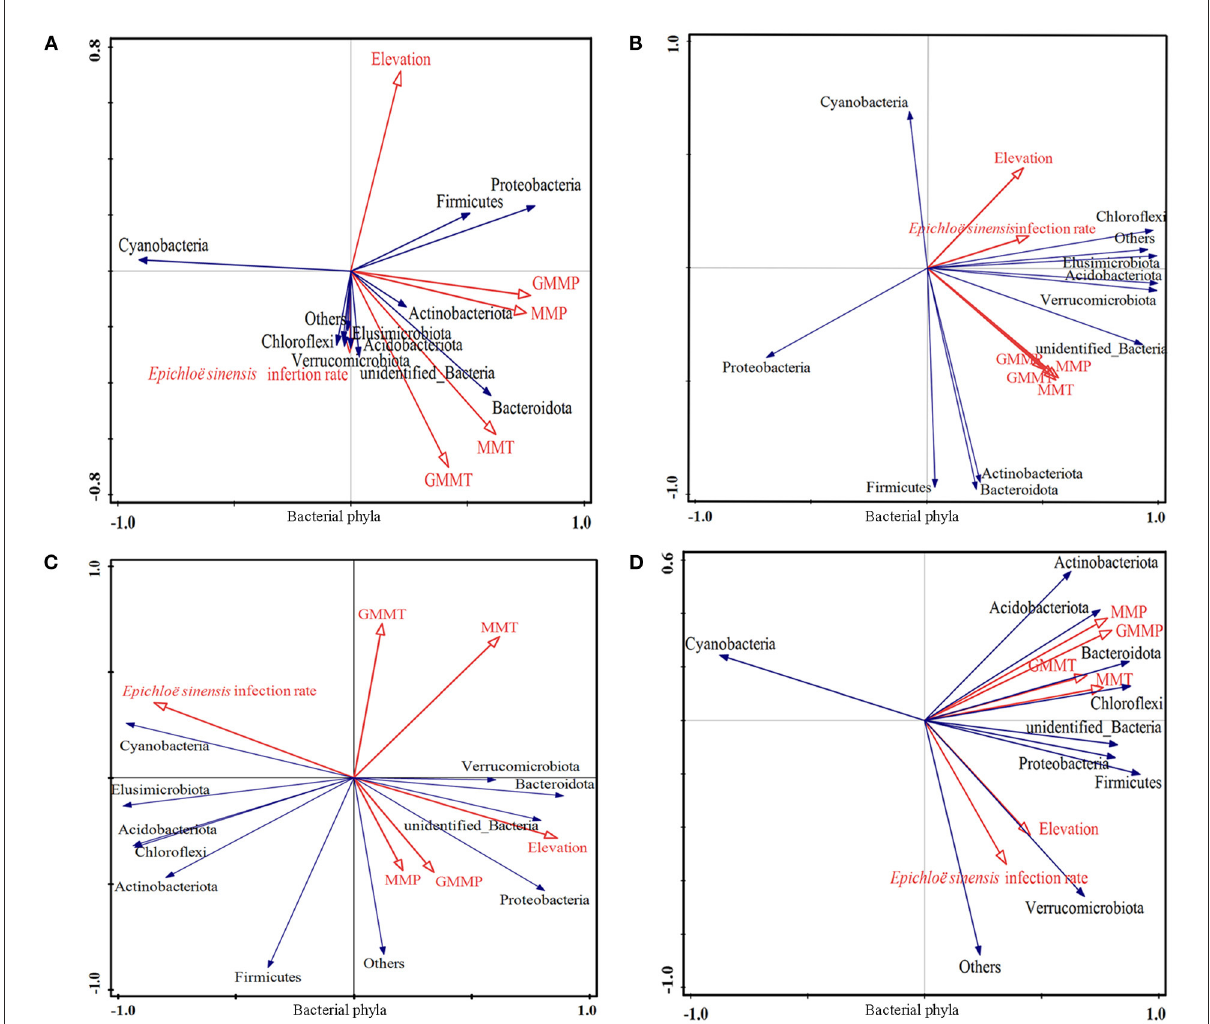
FIGURE5 Effect of environmental factors on bacterial phyla. (A) on overall elevation (2,589–5,197m). (B) on high elevation (2,589–3,000m); (C) on medium-high elevation (3,000–4,500m); (D) and on extremely high elevation (4,500–5,197m). The microbial parameters (expressed as response variables in the RDA) were presented as black line vectors, and the environmental factors (explanatory variables) were presented as red line vectors. MMT, monthly mean temperature; MMP, monthly mean precipitation; GMMT, growing monthly mean temperature; GMMP, growing monthly mean